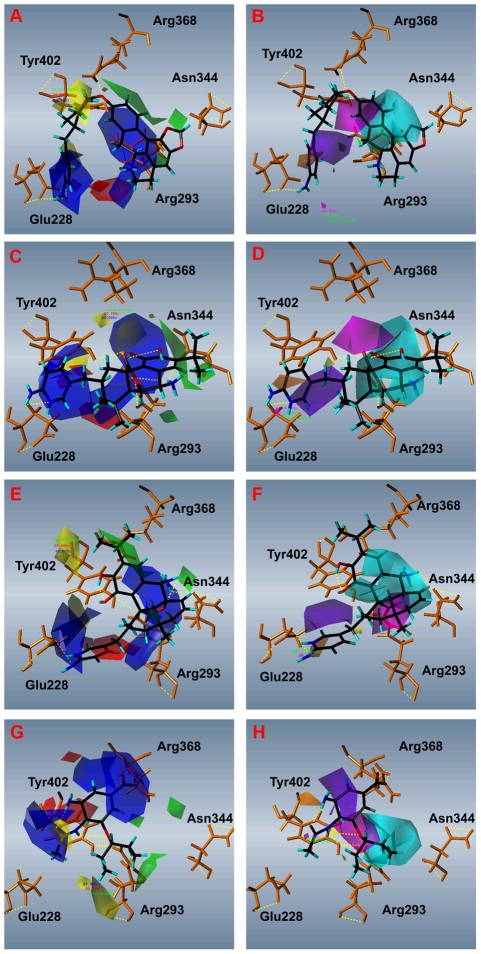
CoMFA (left) and CoMSIA (right) models of the N1 conformation with TCM candidates and Tamiflu® at 20 ns simulation time.Respective CoMFA and CoMSIA models of Xylopine_2 (A, B), Rosmaricine_14 (C, D), Rosmaricine_15 (E, F) and Tamiflu (G, H) are given. Contours in CoMFA represent the following features: favors bulky substituent (green), disfavors bulky substituent (yellow), favors electropositive groups (blue), and disfavors electropositive groups (red). Features in CoMSIA model include: hydrophobic (cyan), hydrophilic (yellow), favorable H-bond acceptor (magenta), unfavorable H-bond acceptor (green), H-bond donor (orange), disfavor H-bond donors (purple).